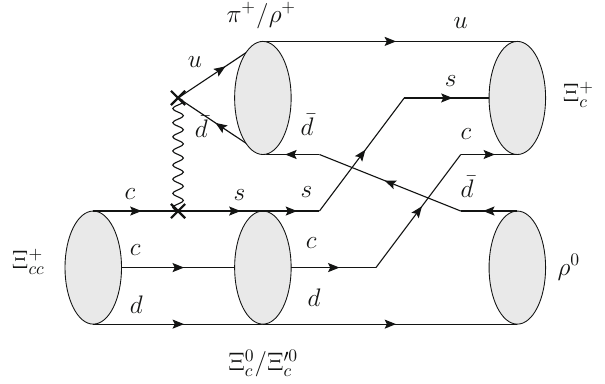
Fig. 3 Substructure of Fig. 2b at quark level. The wave line represents a W + boson Fig. 4 Numbers assigned to the lines in a triangle diagram. The arrows define the momentum directions in our calculation